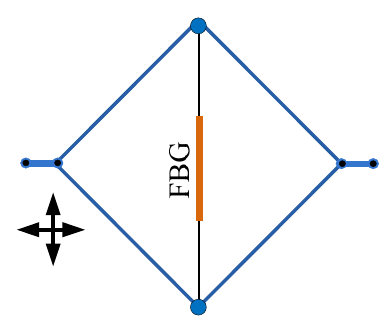
Figure 16. The schematic diagram of polyimide-FBG installed in the rhombus metal structure [81].